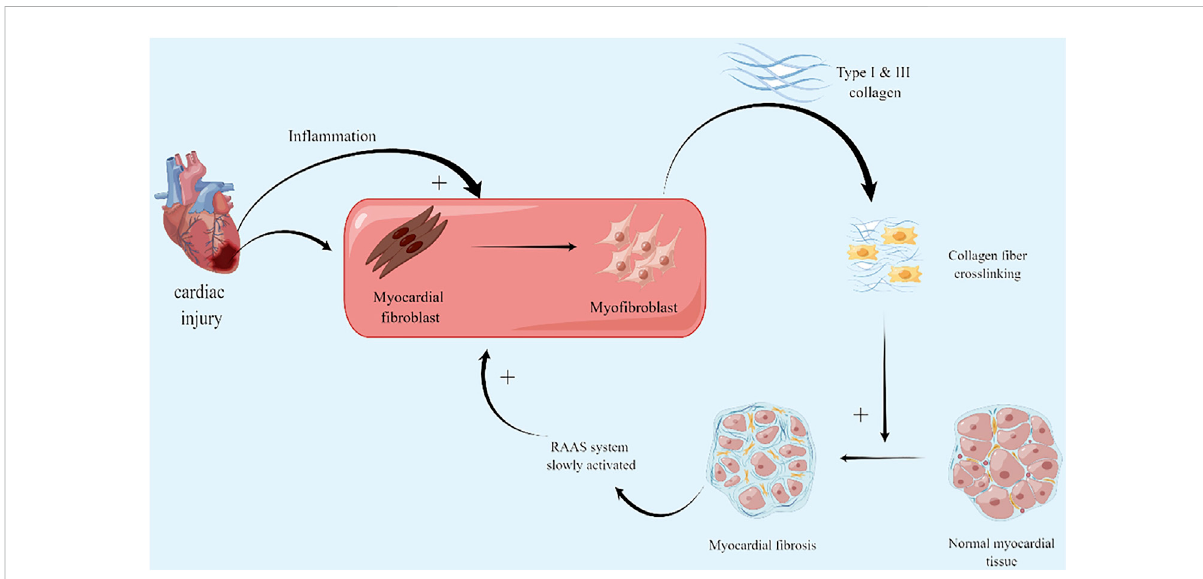
FIGURE 1 Myocardial fi brosis mechanism: fi rstly, activation and differentiation of myocardial fi broblasts after myocardial injury. Excessive deposition of type I and III collagen leads to fi brosis; secondly, RAAS stimulated by fi brotic mechanical stress, increases the burden on the heart, leading to further myocardial damage and aggraving fi brosis. (By